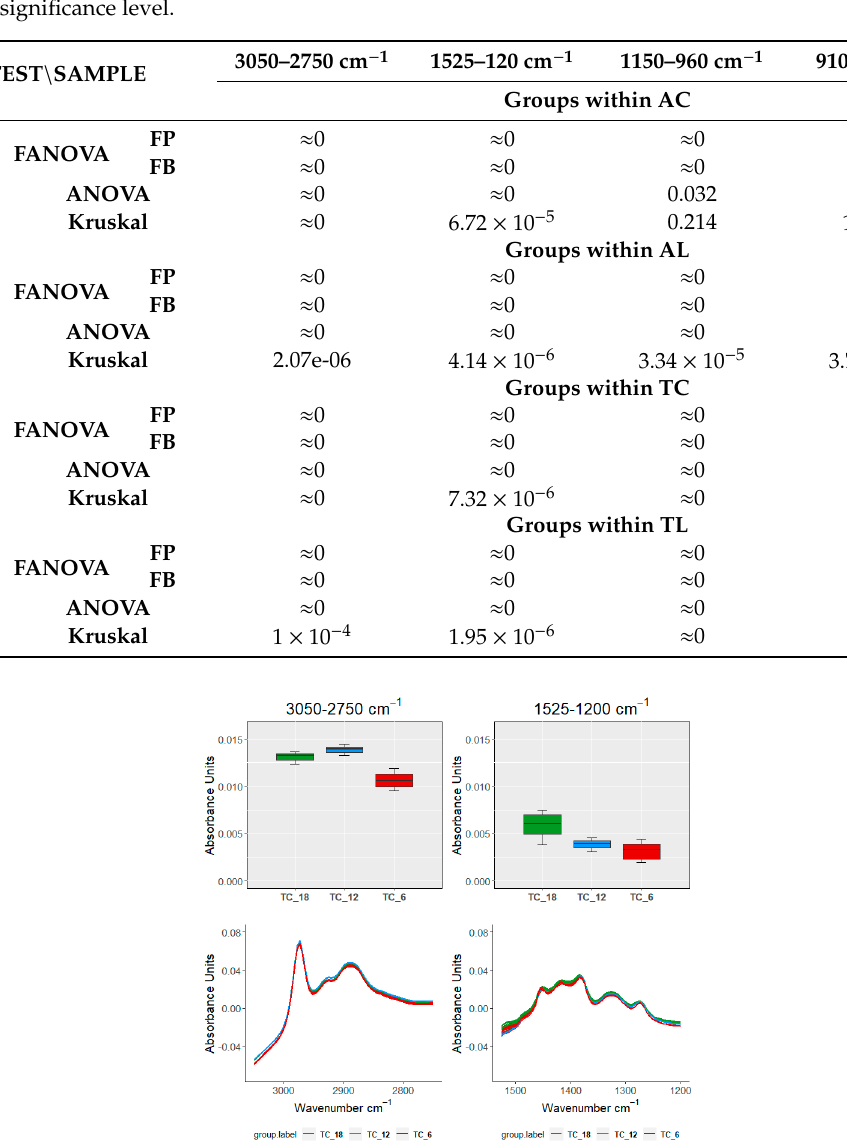
Figure 9. Plots of two of the four significant areas of the Traditional Oak (TL) curves. In the first row, vectorial analysis by means of boxplots. In the second row, FDA through curves in the studied interval. The wine spirit sample is divided into three groups depending on the ageing time (18, 12, and 6 months of ageing). Table 5. Results of the similarity contrast between the three ageing times (18 months, 12 months, and 6 months), depending on the ageing technology. Functional results (FDA) are based on functional ANOVA (FANOVA) using two different tests (FP: permutation test based on a representation of the base function, FB: F test with a reduced bias estimation method). In addition, the results of the ANOVA and Kruskal’s test representing the vectorial results (VA) are shown. All the results are p - values based on a 5% significance level. TEST\SAMPLE